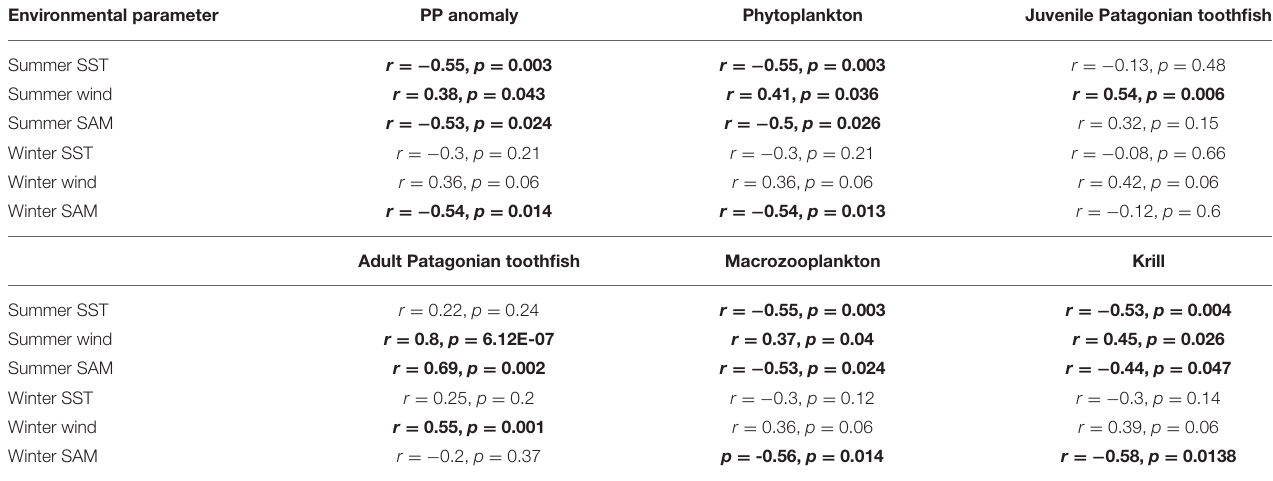
Bold text indicates significant